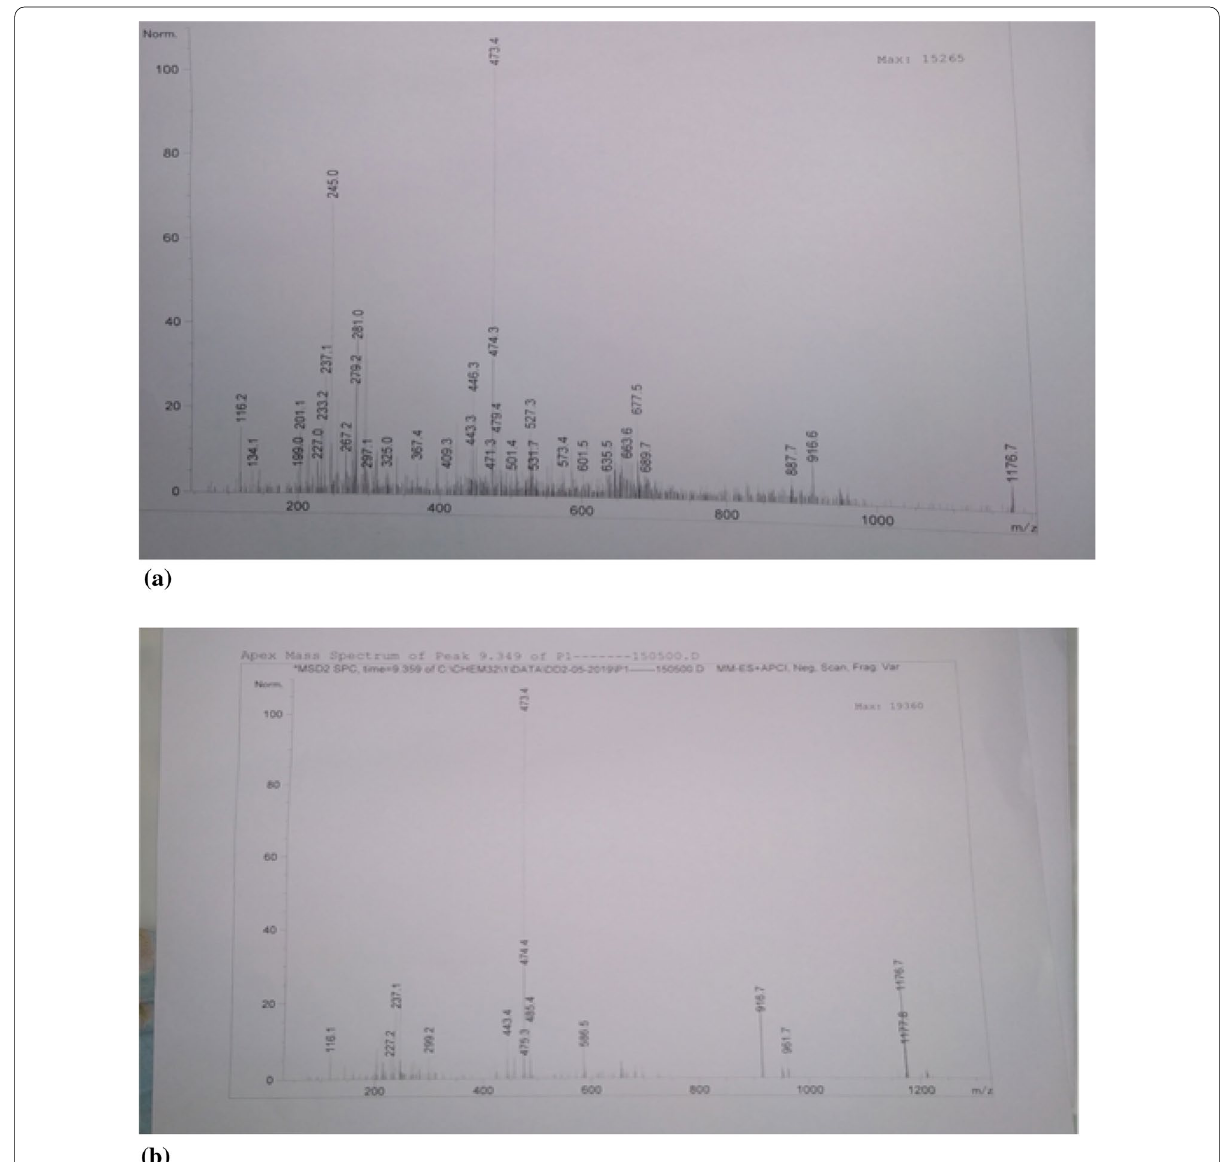
Fig. 2 Phytochemicals profiling of a crude and b partially purified leaf extracts of S.